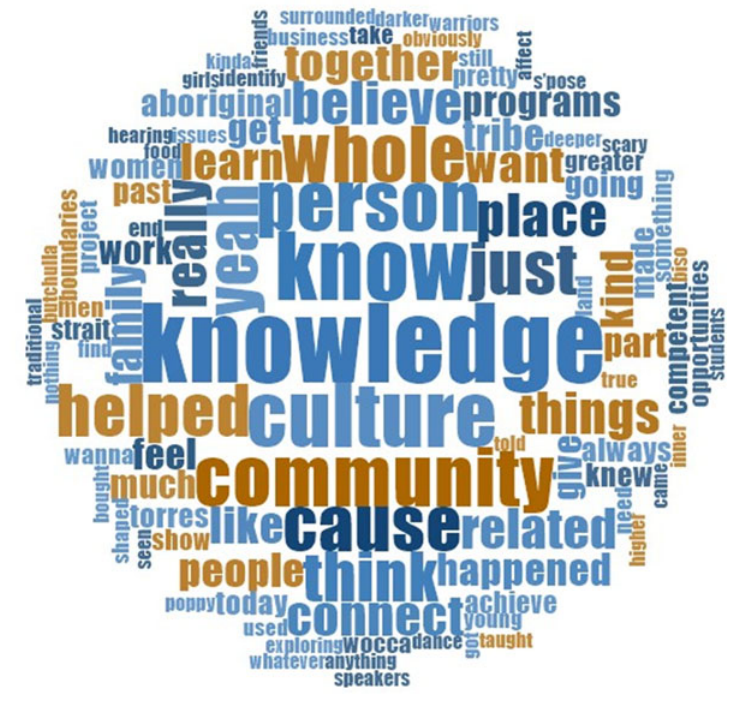
Fig. 1. Tag cloud of participants ’ perceptions of the impact of Burunga M Gambay on their identity.